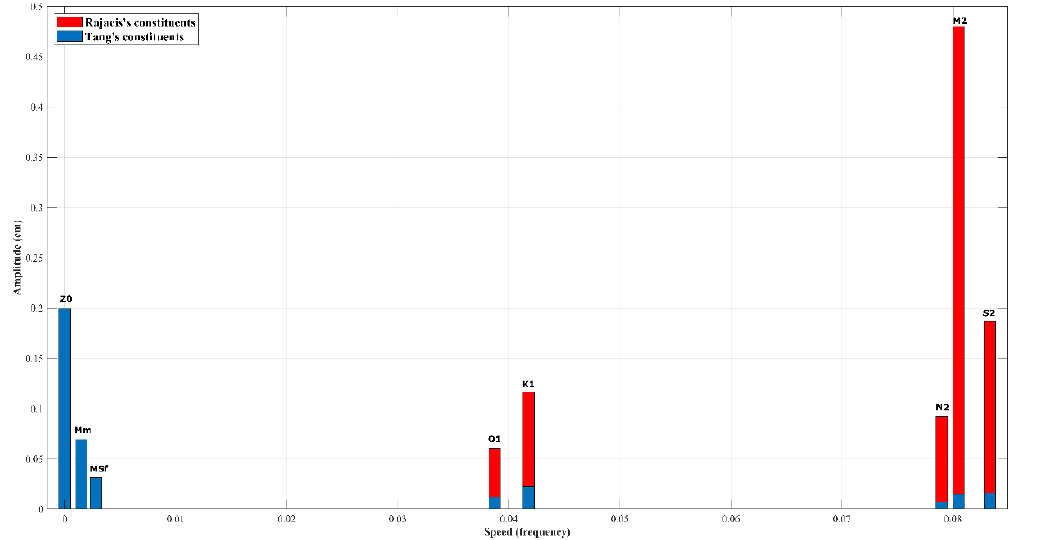
Figure 6. Shahid Rajaei's and Tang ports